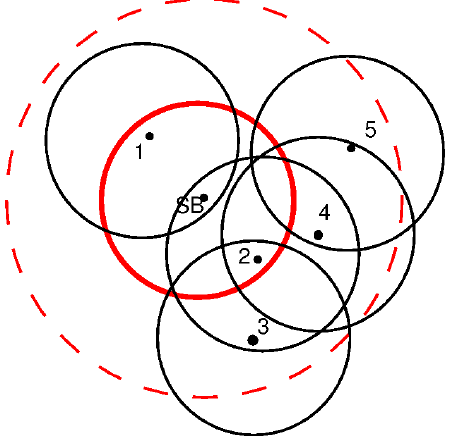
Figure 10. Case 1: deployment and transmission